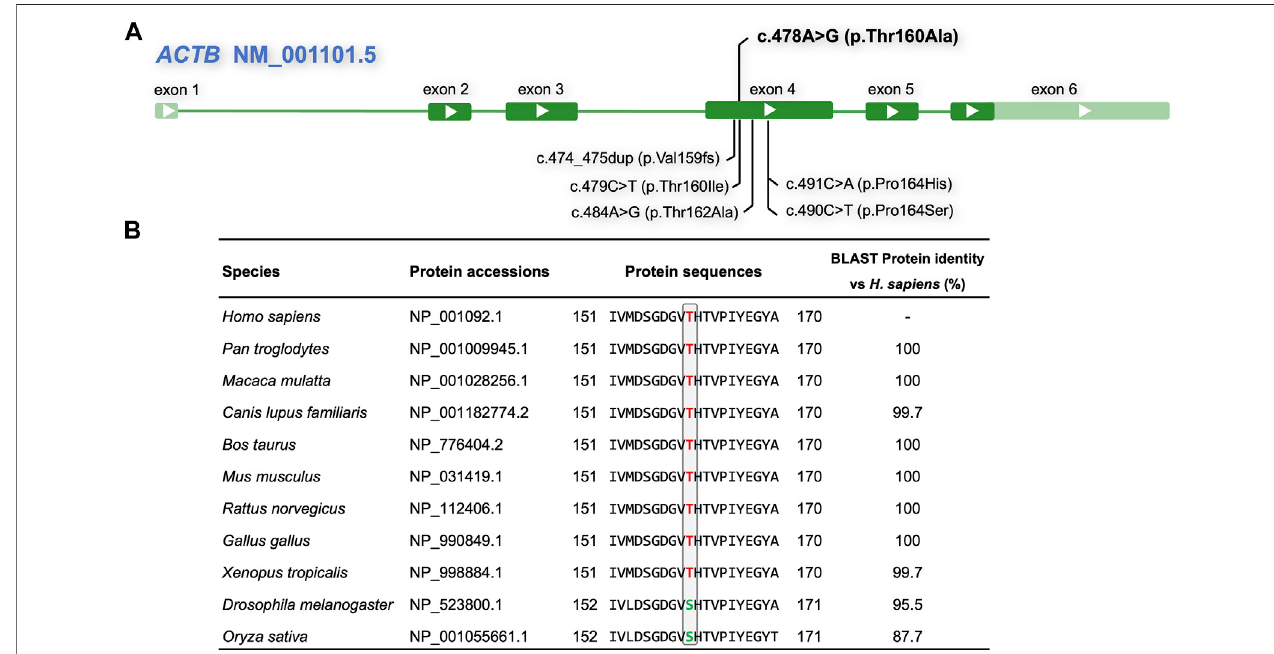
FIGURE3| Outlineofthe ACTB geneandvariants,andconservationanalysis. (A) Compilationofthenovelp.Thr160Alaandadjacent ACTB variantsreportedinthe literature and the ClinVar database associated with BWCFF. (B) Multiple alignments showing amino acid conservation at the mutant sites across the indicated species; red letters indicate conserved threonine, whereas green letters indicate serine, which is a hydrophilic amino acid with a hydroxyl group on the side chain like threonine.